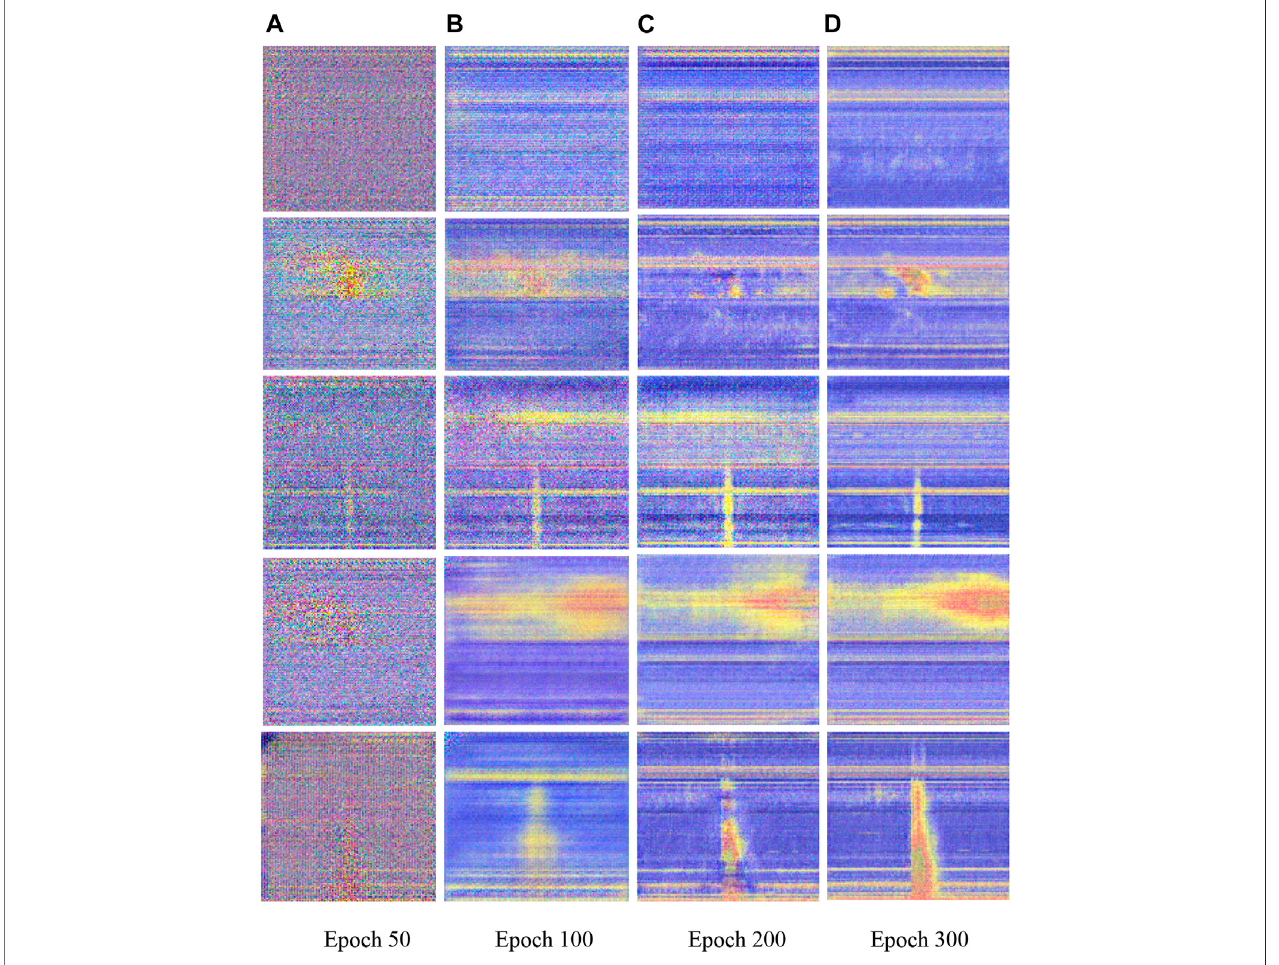
FIGURE6| C-GCGANgenerateddataimagesofthe fi vetypesofsolarradioburstsatdifferentepochnumbers(50 – 300).Panelsfromtoptobottomcorrespondto type I to type V bursts.